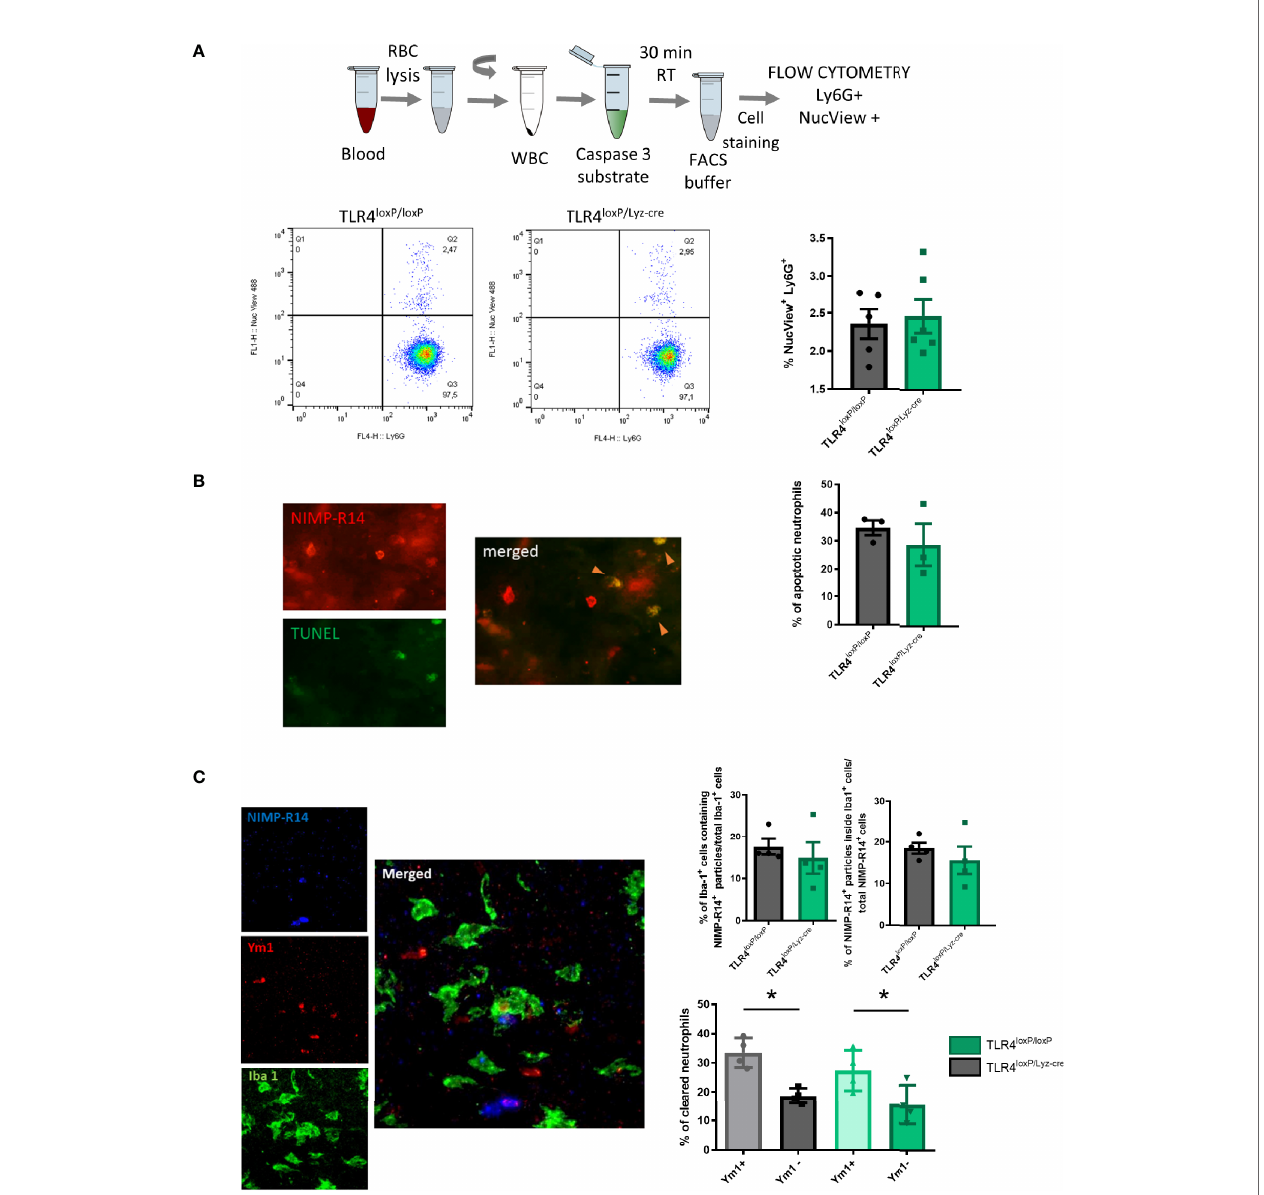
FIGURE 2 | Neutrophil apoptosis and microglia engulfment. (A) Top: Experimental design: blood was collected, RBC lysed, WBC resuspended and fi nally caspase 3 substrate was added and incubated with the WBC for 30 min at RT. After incubation, cells were stained for Ly6G marker and samples were analyzed with a fl ow cytometer. Bottom: Flow cytometry analysis of the percentage of apoptotic neutrophils in blood (NucView + /Ly6G + ). (B) TUNEL assay was performed in fi xed brain slices and after they were stained with a neutrophil marker (NIMP-R14). Total number of neutrophils [NIMP-R14 + cells (top left)] was quanti fi ed. Double positive cells (NIMP-R14 + /TUNEL + cells, right) were quanti fi ed as apoptotic neutrophils (orange arrowheads). Percentage of apoptotic neutrophils in fi ltrated in the ischemic tissue from TLR4 loxP/loxP mice and TLR4 loxP/LyzM-cre mice (n=3). (C) Preferential phagocytosis of N2 neutrophils by microglia. Left: Representative phagocytosis micrograph showing neutrophil staining (NIMP-R14 + cells, blue), N2 marker (Ym1 + cells, red) and microglia (Iba1 + cells, green) and all merged channels showing an N2 neutrophil engulfed by microglia. Right top: Percentage of phagocytic microglia in TLR4 loxP/loxP mice and in TLR4 loxP/Lyz-cre mice (n=4) and percentage of neutrophils engulfed by microglia normalized by the total number of neutrophils (n=3). Right bottom: Quanti fi cation of clearance of speci fi c neutrophil population (Ym1+/Ym1-) (*P < 0.05, n=4). Data are mean ±